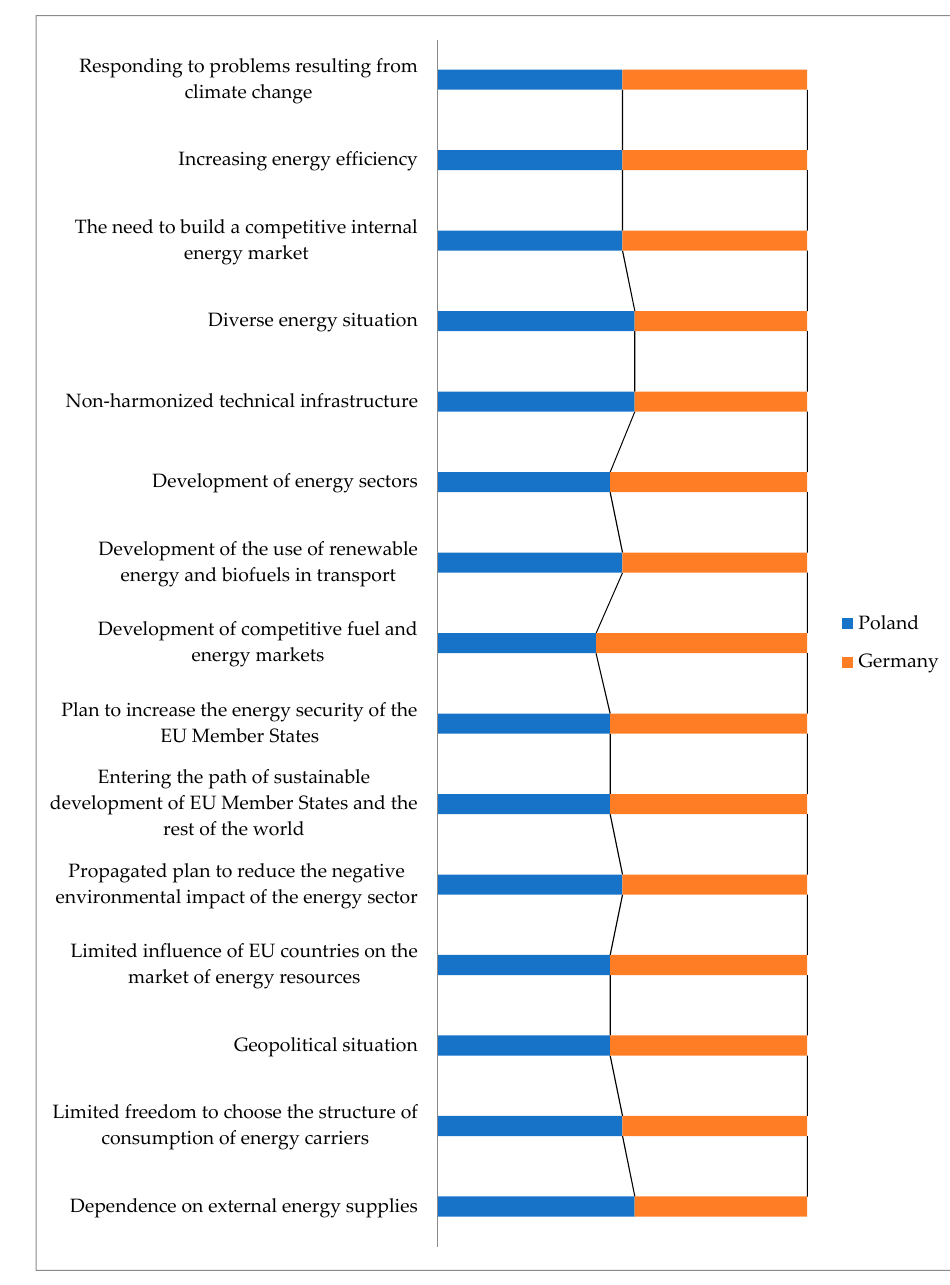
Figure 30. Comparison of the issued opinion on the way of thinking of Poland and Germany (%).